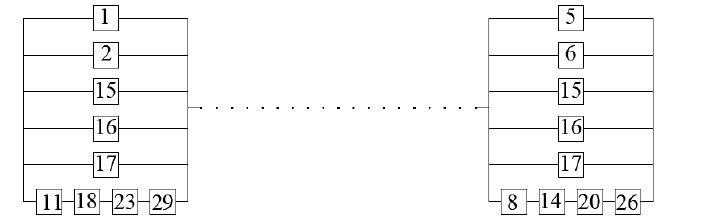
Figure 9. Schemes of the reliability system of truss “B” after the first reduction.